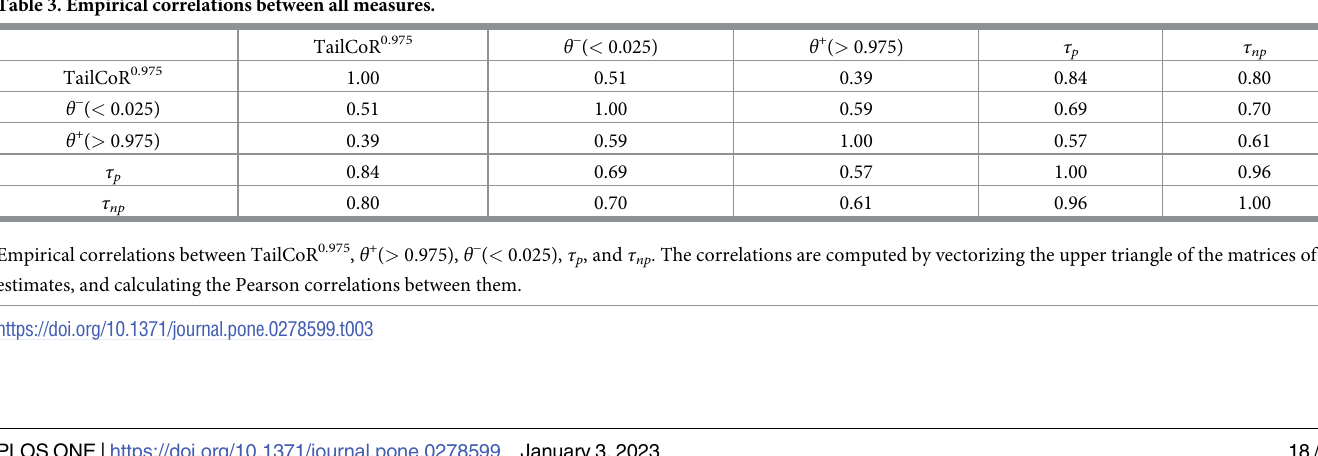
Table 3. Empirical correlations between all measures.